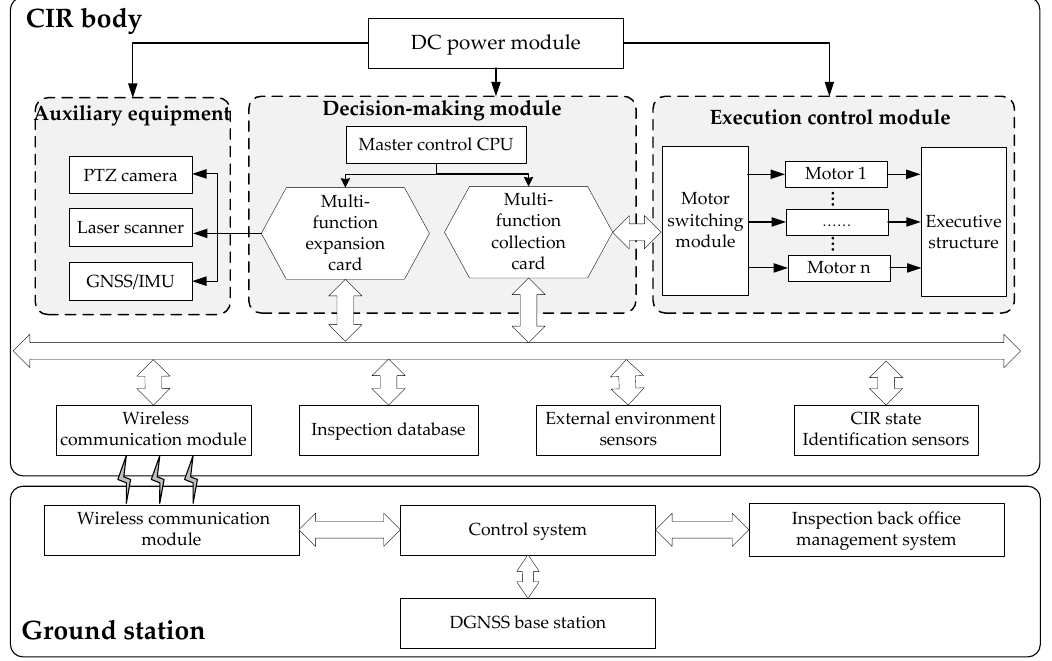
Figure 1. Overall design of CIR autonomous inspection system.